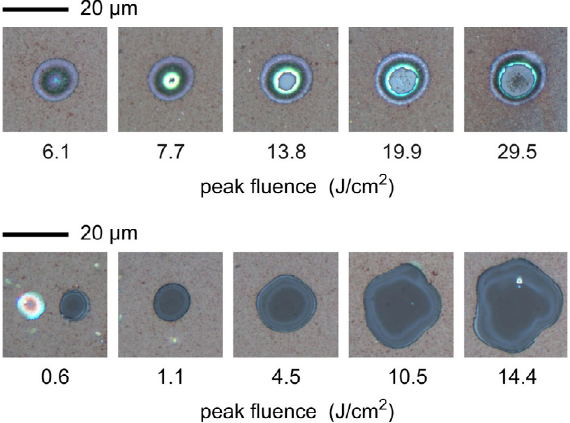
Fig. 4. Microscope images of single ablation spots. Upper row: irradiation from the TCO side; lower row: irradiation from the glass